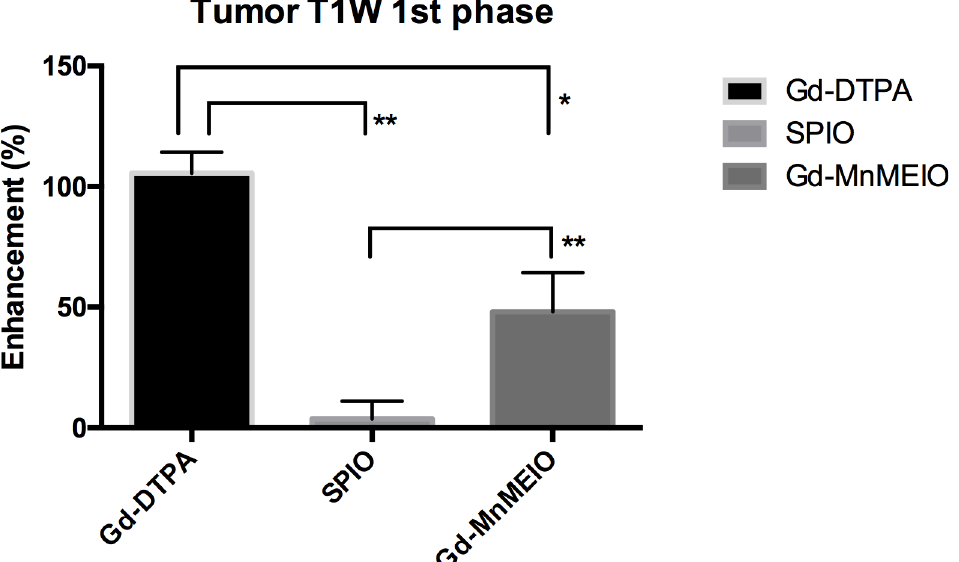
Fig 9. T1 enhancement of tumor in the first phase of dynamic contrast-enhanced T1-weighted images with Gd-DTPA (n = 4), SPIO (n = 7), and Gd- MnMEIO (n = 5). The error bars indicate standard deviation. Significant differences are indicated by * p < 0.05 and ** p <